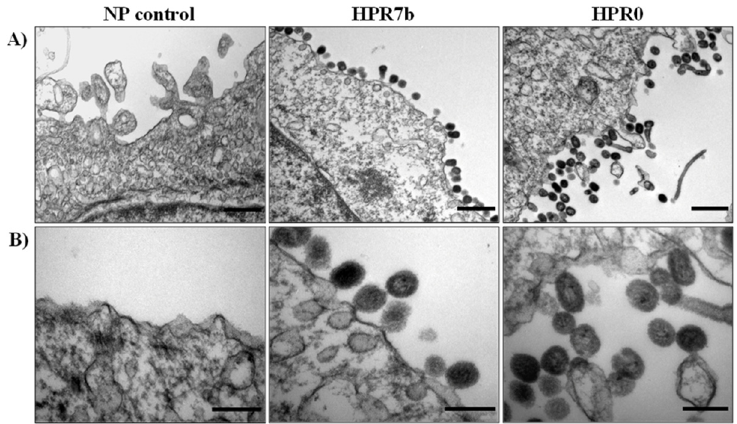
Figure 2. Viral particle morphology of rescued rISAV. EM imaging of ASK cells infected with either rISAV-HPR7b or rISAV-HPR0 at 4 dpi. ( A ) Representative transmission electron micrographs of ASK cells incubated with supernatants from NP control passage 3, rISAV-HPR7b, and rISAV-HPR0. Line in B panel: 500 nm. ( B ) Magnification of ( A ) images. Line in A panel: 200 nm.